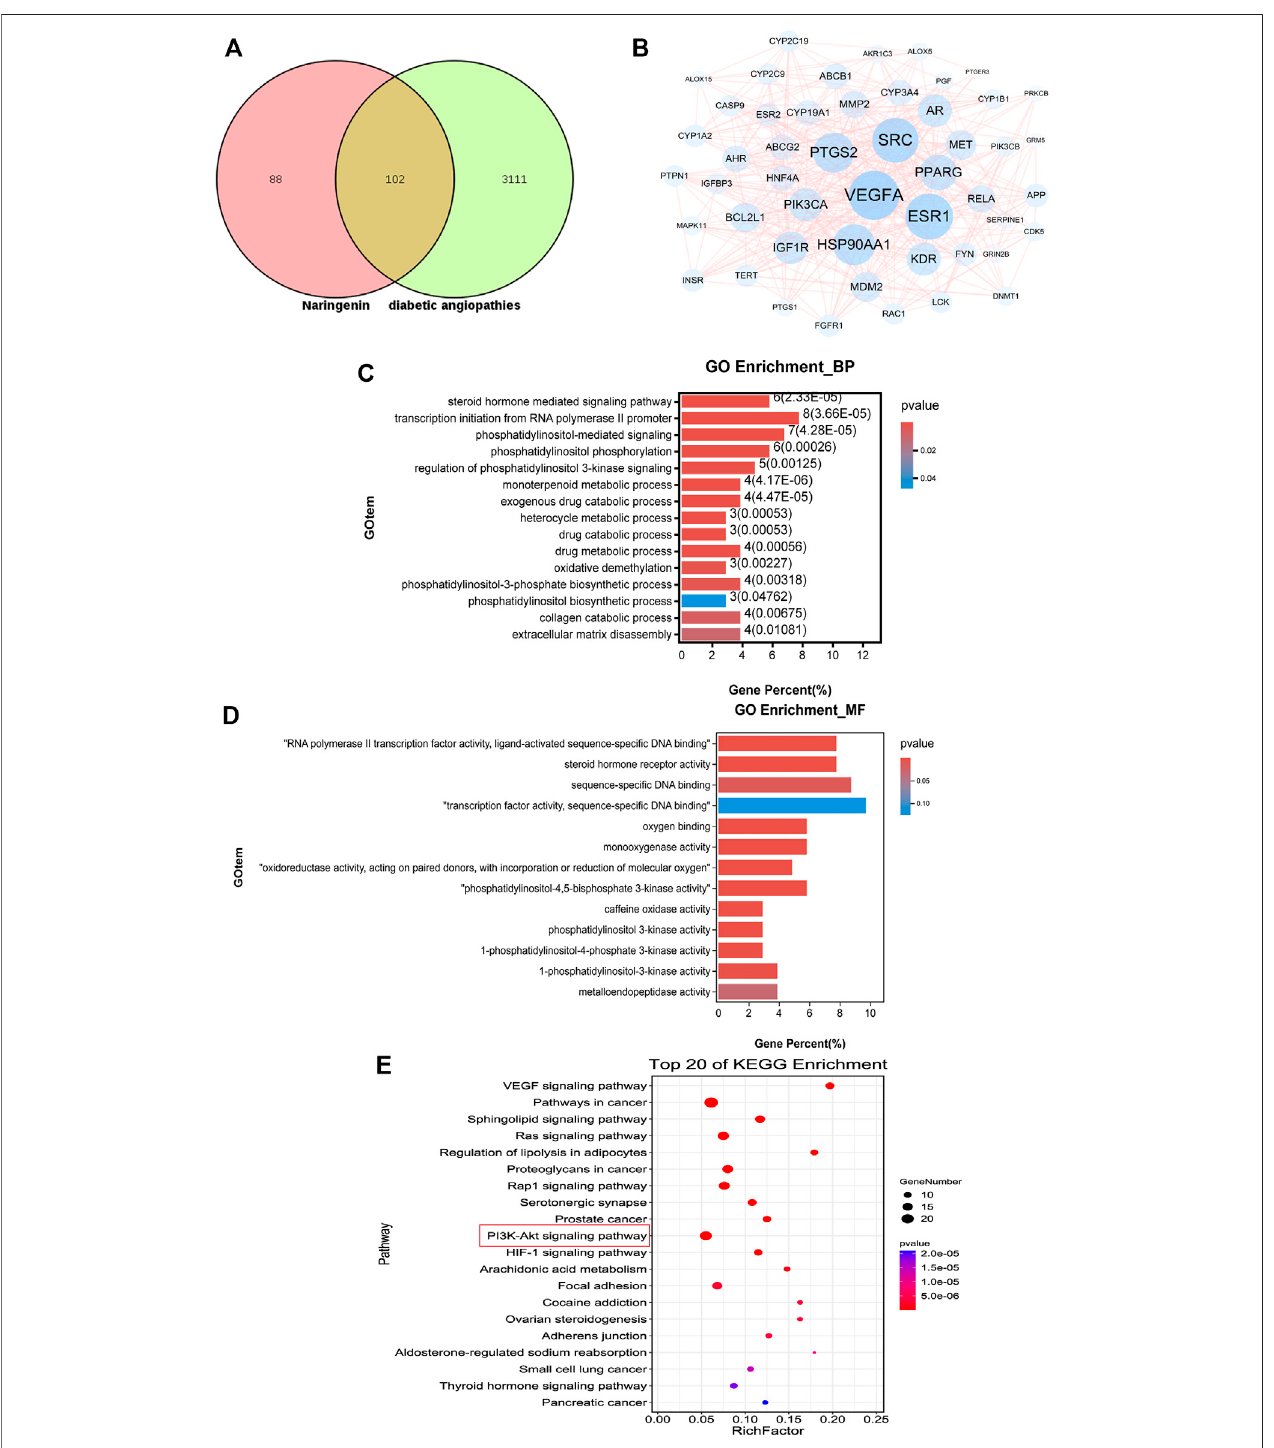
FIGURE 6 | Results of network pharmacology analysis. (A) Venn diagram shows the number of common targets between Nar and diabetic angiopathies. (B) Protein – proteininteraction(PPI)networkofthecommontargetsaccordingtodegreevalueanalyzedbyCytoscapesoftware. (C) GOenrichment(BP)analysisofnetwork pharmacology. (D) GO enrichment (MF) analysis of network pharmacology. (E) Top 20 most enriched KEGG categories for the common targets shows the vital Nar- related signaling pathway against diabetic angiopathies according to network pharmacology analysis.